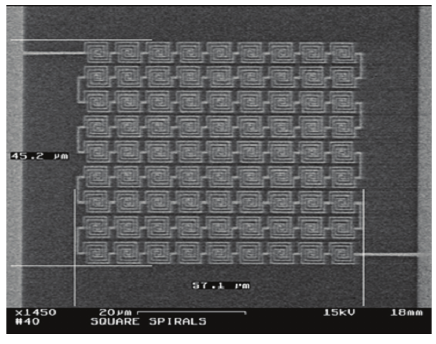
Figure 1: SEM micrograph a spiral antenna fabricated by Kotter et al.